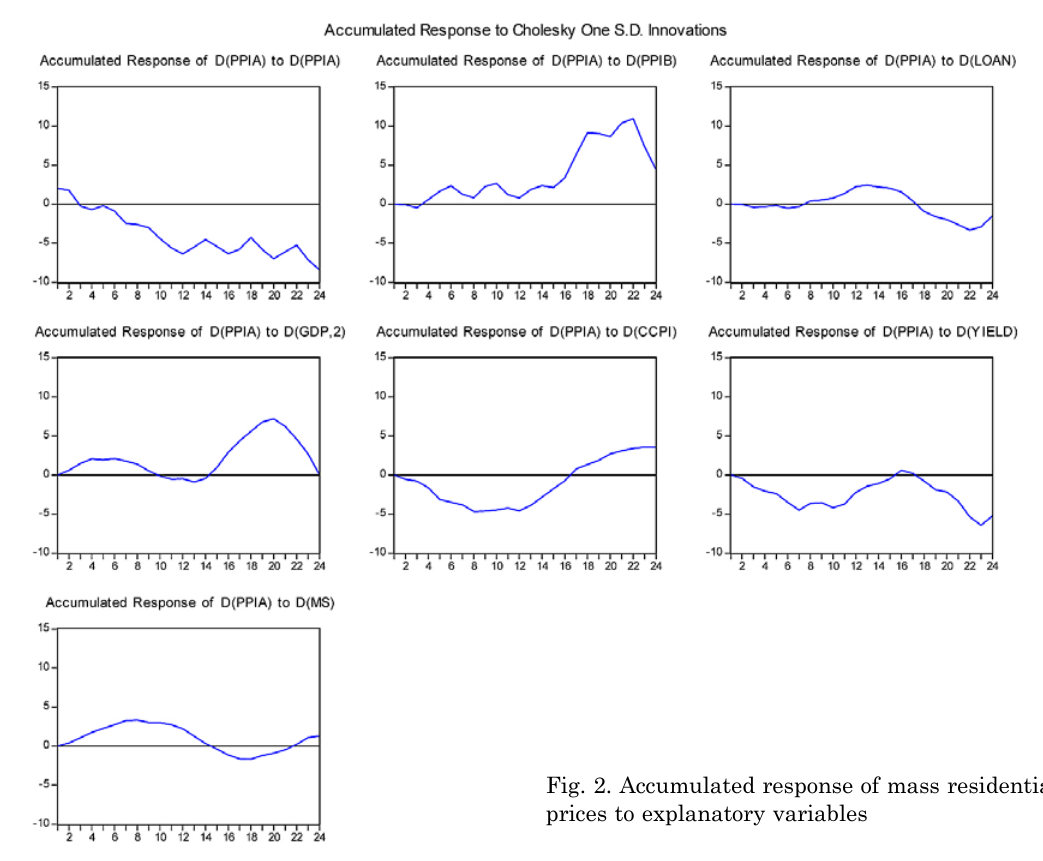
Fig. 2. Accumulated response of mass residential prices to explanatory